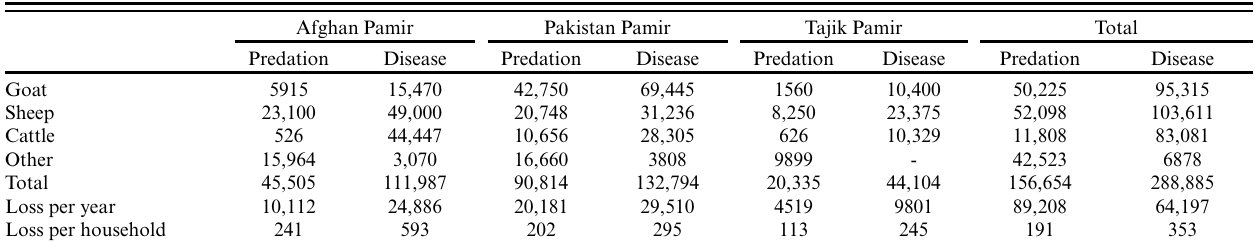
Table 3 . Annual monetary losses (US$) incurred by Pamirians due to livestock depredation by predators and diseases.